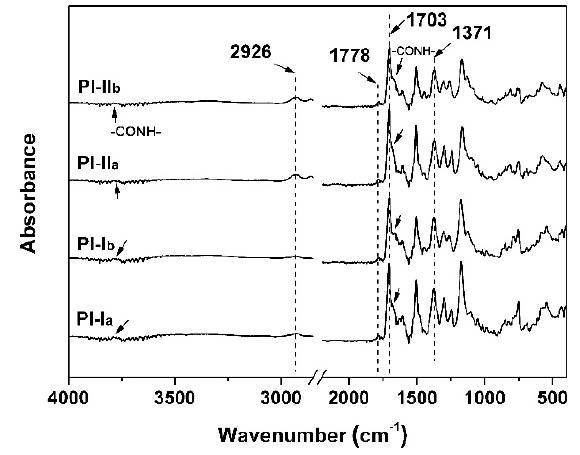
Figure 3. ATR-FTIR spectra of PI resins.